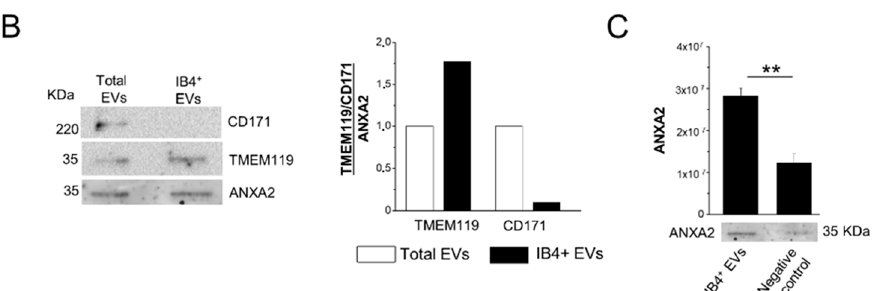
Figure 2. Characterization of total and IB4-positive EVs. ( A ) Representative size distribution of total and IB4-positive (IB4+) EVs detected by TRPS. ( B ) Representative Western blot and relative quantification of microglial TMEM119 marker and neuronal CD171 marker in total EVs and IB4+ EVs. CD171 and TMEM119 expression are normalized to ANXA2 staining. ( C ) Expression and quantification of EV marker ANXA2 in IB4+ EVs and negative control (IB4-coated beads pretreated with melibiose) (n = 3). Data are shown as mean ± SEM. ** p < 0.01, one-way ANOVA, Tukey’s multiple comparisons test.